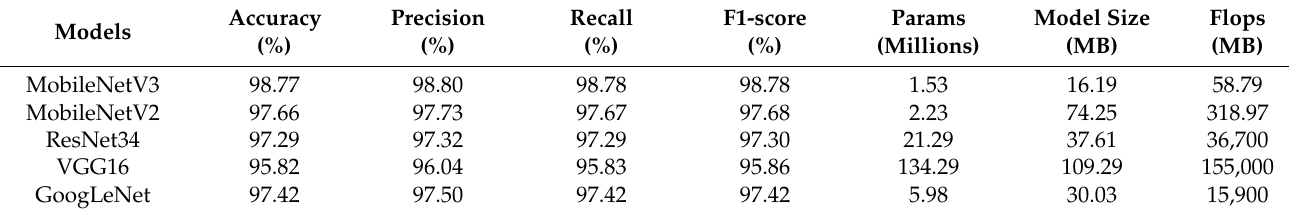
Table 2. Comparison of the five models.